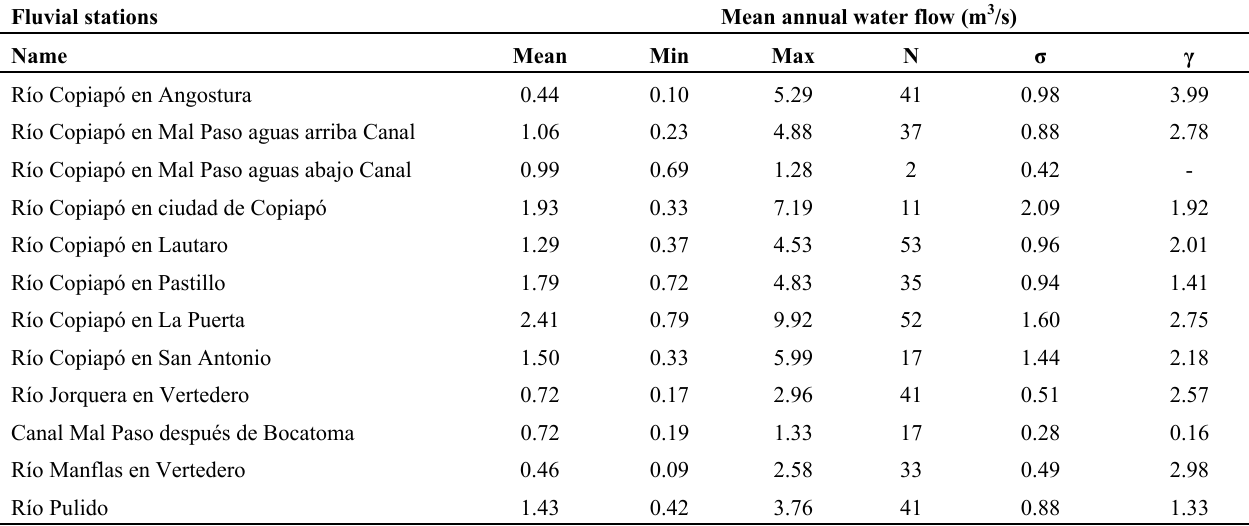
Table 2. Mean annual water flows in the basin and main statistics.